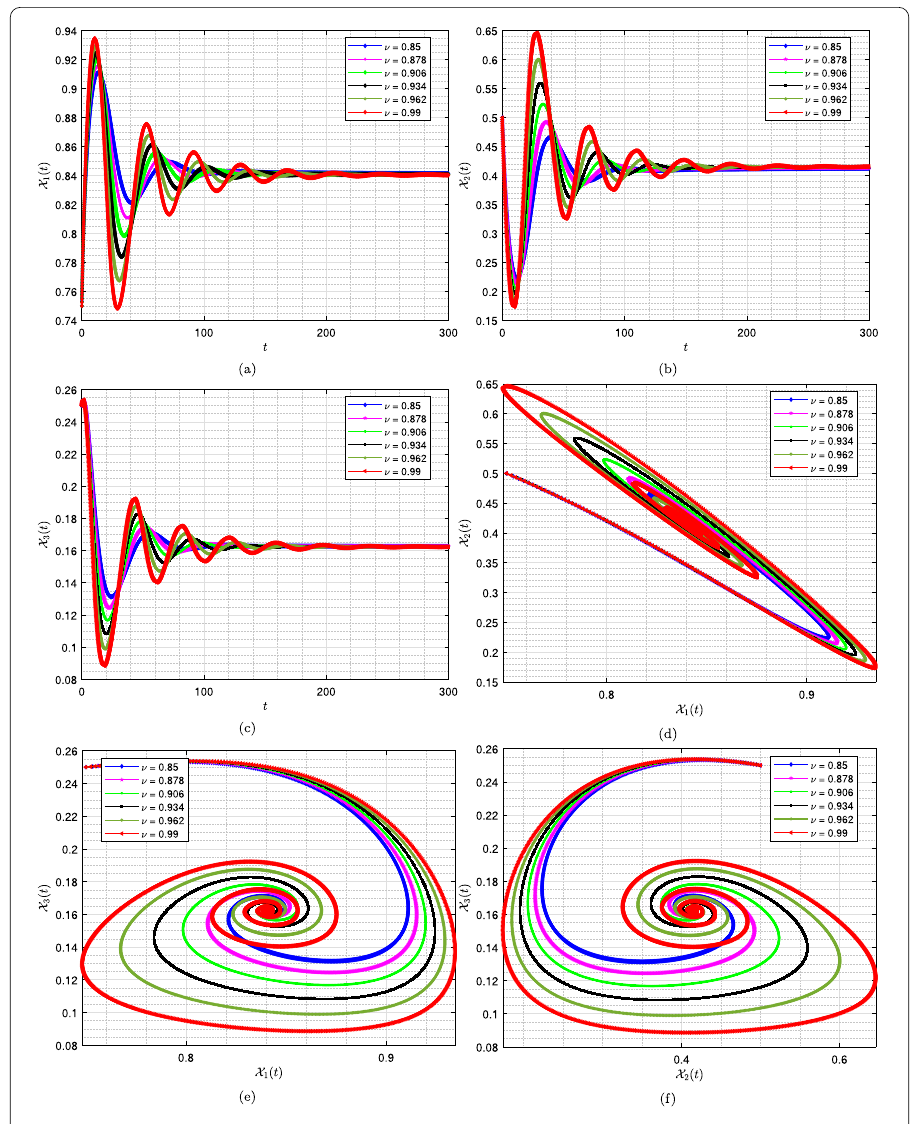
Figure 1 Dynamics for system (19) for different parameters in